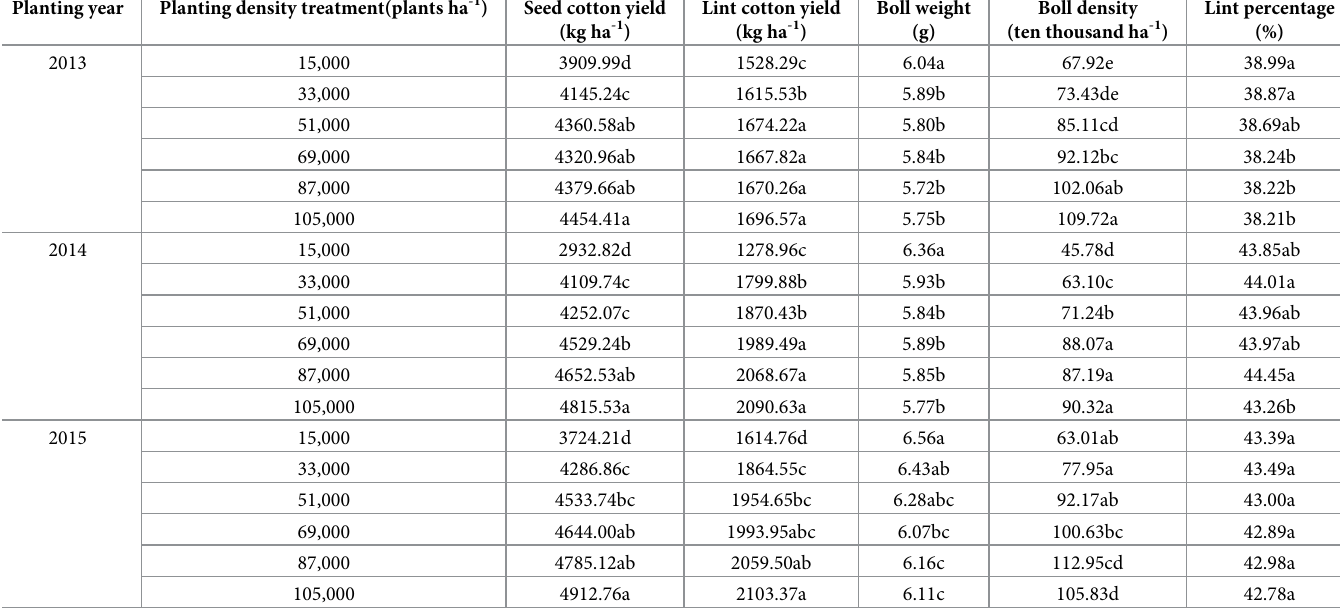
Table 2. Yield and yield components of cotton under different planting densities from 2013 to 2015. Planting year Planting density treatment(plants ha -1 )